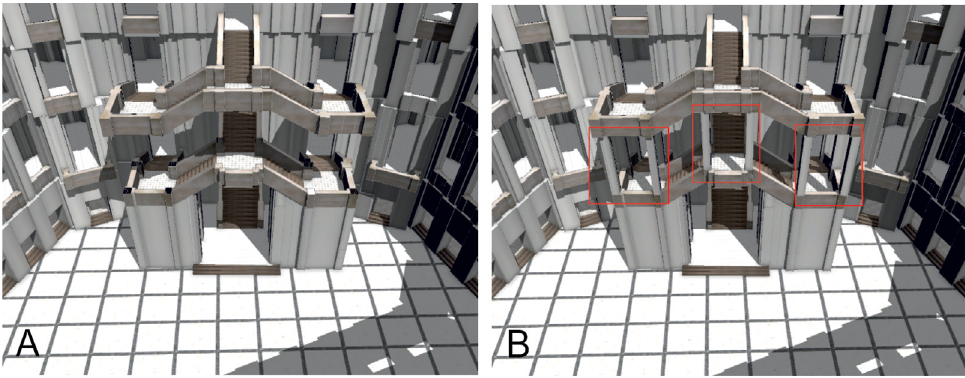
Fig. 3. The appearance of the staircase: A) before the corrections, B) after adding the pillars